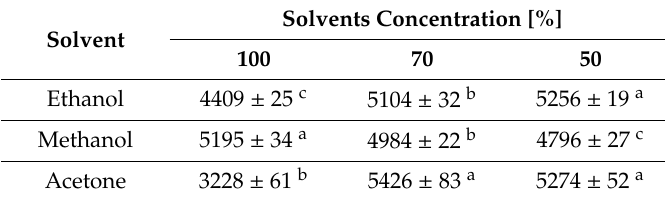
Table 1. The total phenolic compounds in Japanese quince fruit, mg / 100